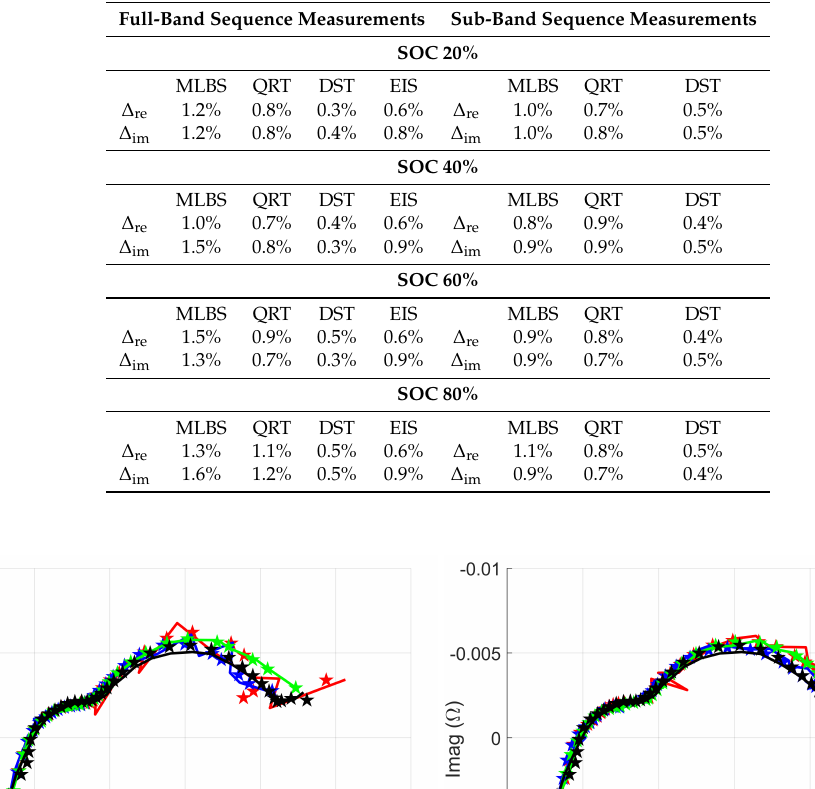
Table 3. K–K compliance test mean residuals